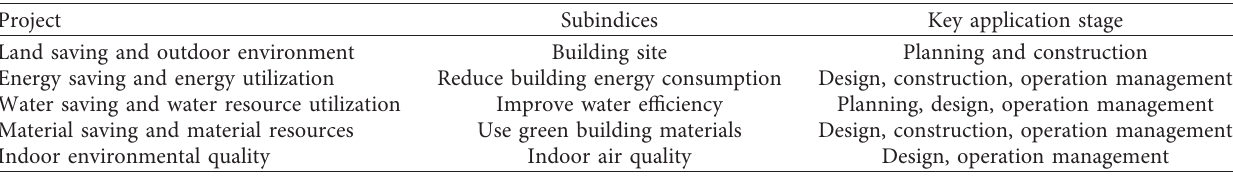
Key application stage